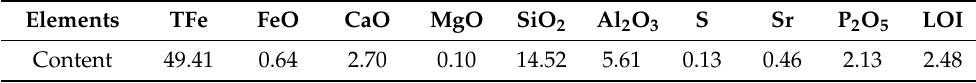
Table 1. Chemical compositions of HPOHO